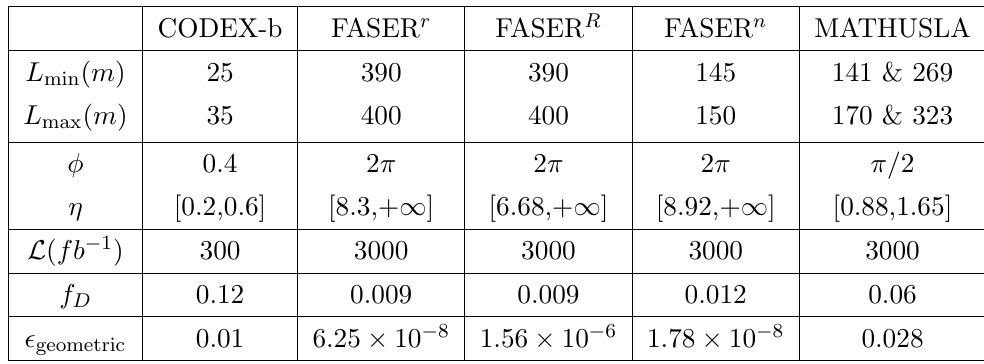
Table 1 . Summary of the di(cid:11)erent detector parameters. The FASER proposal [9] discusses three di(cid:11)erent possible setups: FASER r is the far detector with small radius r = 0 : 2 m, while FASER R is the far detector with large radius R = 1 m; FASER n is the near detector con(cid:12)guration with radius 0 : 04 m. Here, L min / L max are the minimum/maximum distance of the detector from the IP. For MATHUSLA the distances at the near end and the far end are given separately. (cid:30) : azimuthal angle coverage. (cid:17) : pseudo-rapidity range covered by the detector. L : luminosities used in the